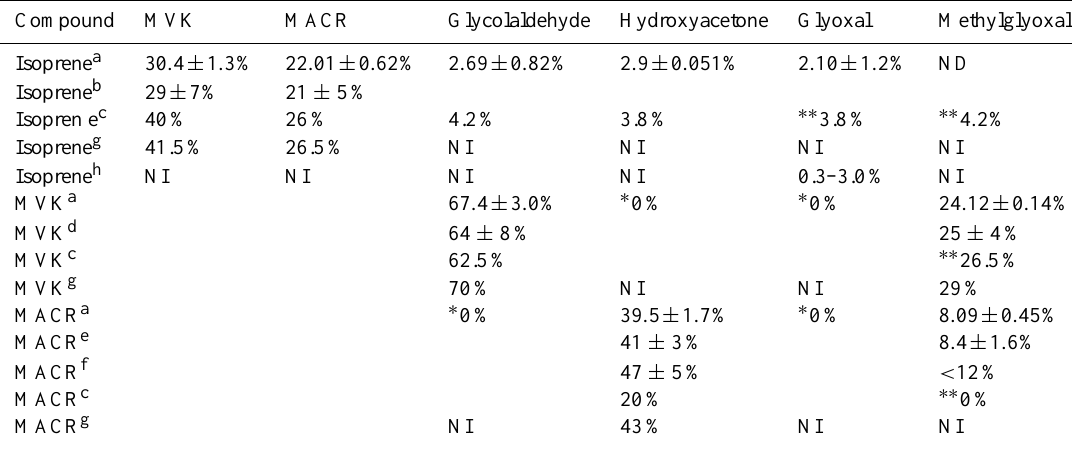
Table 1. First-generation yields from high NO x experiments. All yields and errors are in percent. All uncertainties presented in this work represent the 1 σ error. The MCM yields are calculated for the reaction with OH and on the basis that the fate of peroxy radicals is dominated by NO with negligible contribution from reaction with HO 2 or RO 2